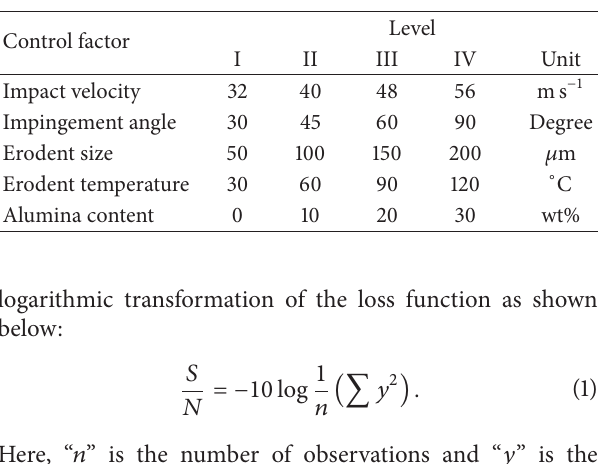
Table 2: Levels of the variables used in the